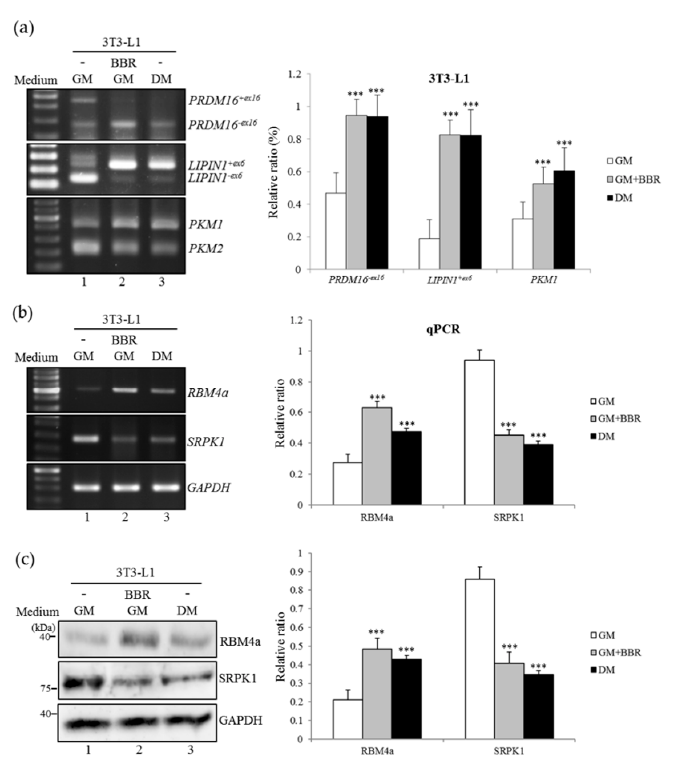
Figure 2. Berberine treatment reprograms the brown adipocyte-related splicing network. ( a ) 3T3-L1 cells were cultured in the growth medium, BBR-supplemented growth medium (5 μ M), or Rosiglitazone-supplemented differentiation medium for 48 h. Total RNAs were extracted and subjected to RT-PCR analyses with indicated primer sets listed in Table S1. The bar graph shows the percentage isoform index (PII), which presents relative levels of spliced transcripts. ( b , c ) Total RNAs and cell lysates prepared from the parallel experiments were subjected to RT-PCR, qPCR, and immunoblot assays using specific primer sets, listed in Table S1, and specific antibodies. Quantitative results are presented as the mean ± SD ( n = 4), and statistical significance was calculated using the student unpaired t -test (*** p < 0.005).